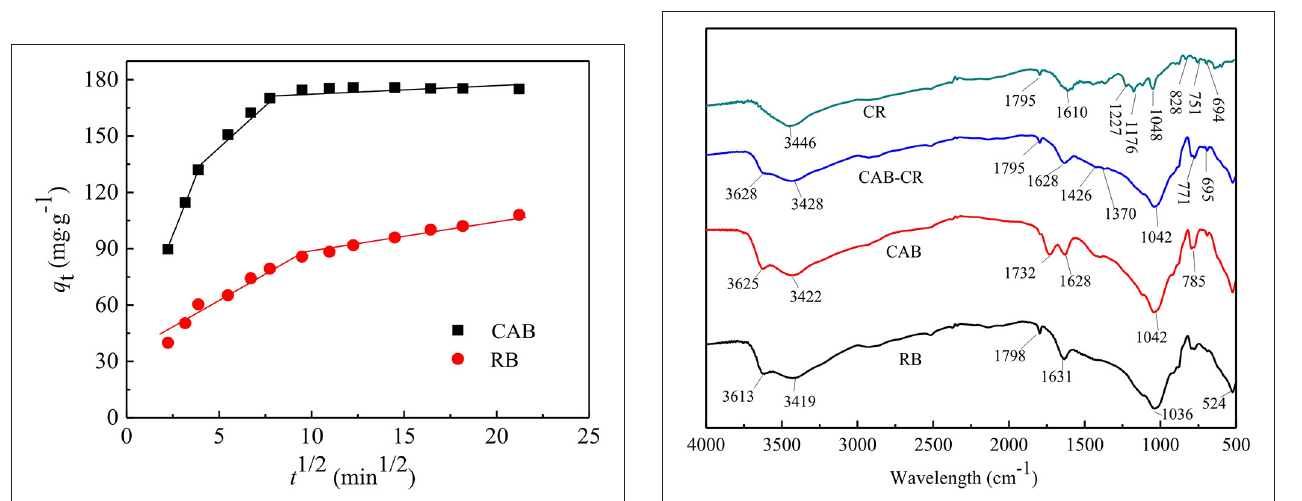
FIGURE 7 | Intra-particle diffusion model of CR adsorption on RB and CAB. FIGURE 8 | FT-IR spectra of RB, CAB, and